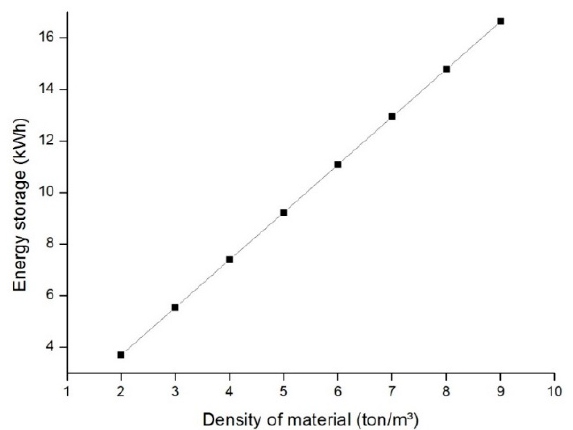
Figure 5. The behavior of the amount of energy stored as a function of the density of the material of the block.